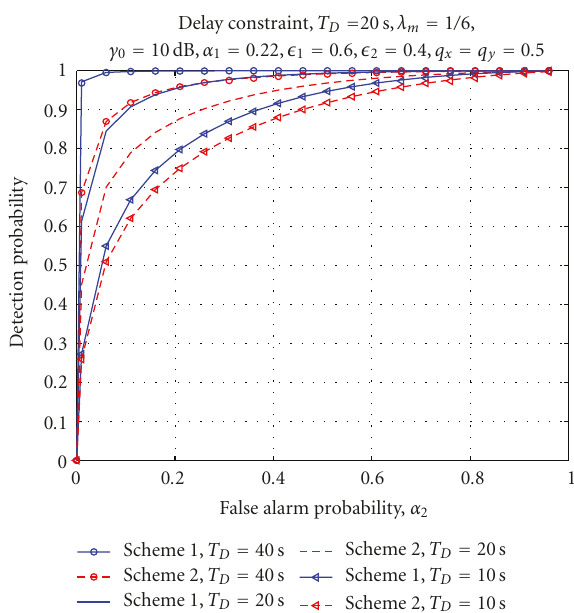
Figure 7: ROC curves for two decision fusion models when the delay constraint is 20s: T s = 1s, v = 1 m/s, γ 0 = 10 dB, p = 0, q x = q y = 0 . 5, α 1 = 0 . 22, λ m = 1 / 6, (cid:2) 1 = 0 . 6, (cid:2) 2 = 0 . 4 .